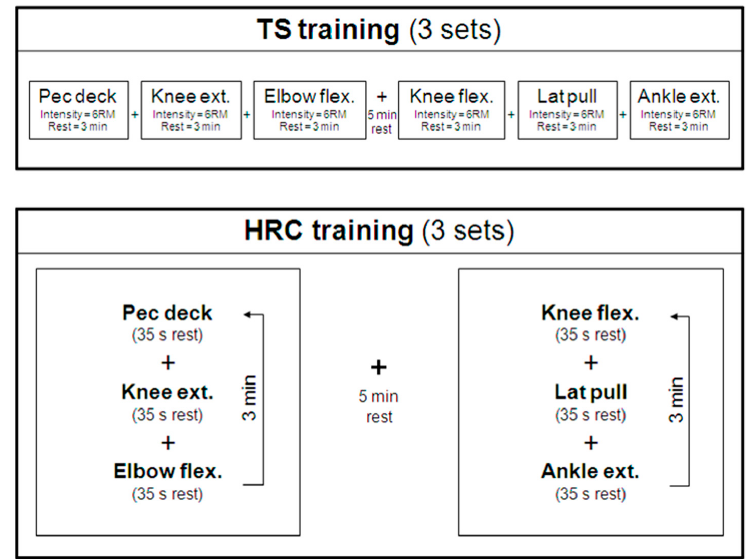
Figure 1. Experimental design. HRC = high-intensity resistance circuit-based training; TS = traditional strength training; ext. = extension; flex. = flexion. See text for more details.